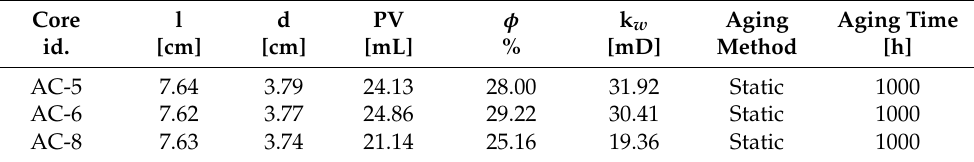
Table 4. Core data for Austin chalk and an overview of